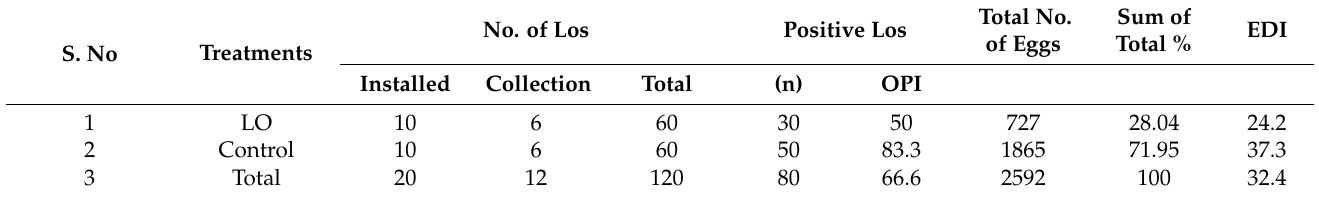
Table 1. Effects of Lethal ovitraps in the field.